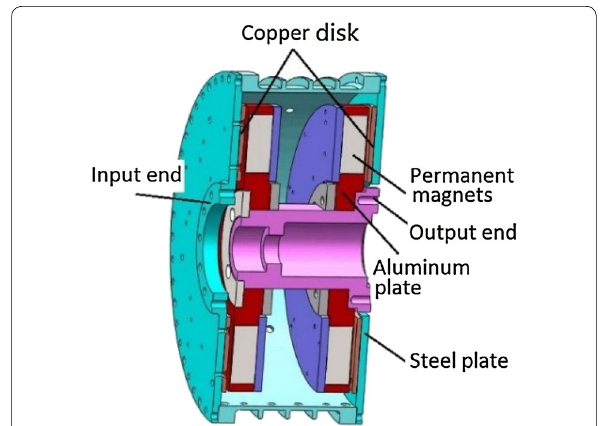
Figure 2 Structure diagram of coupling body